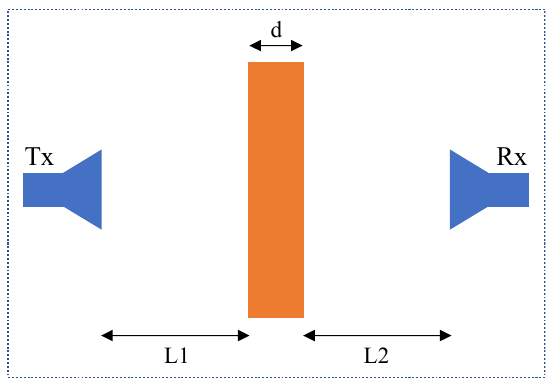
Figure 3. The bistatic experiment setup.